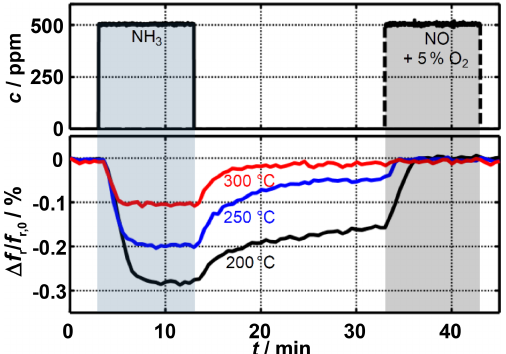
Figure 4. Resonant frequency shift during adsorption as well as free and (by addition of NO) forced desorption of